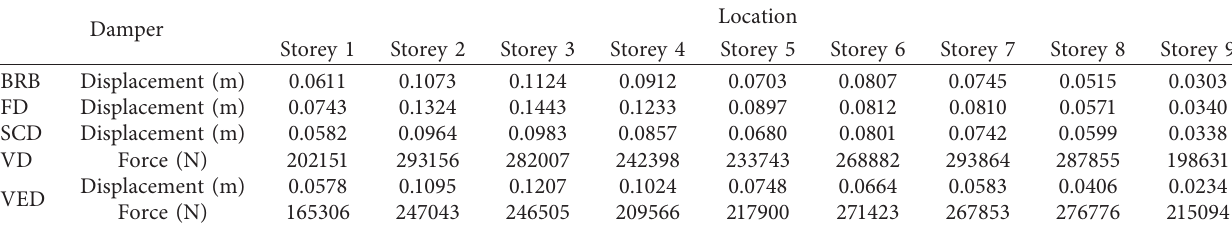
Table 4: Limit values of displacement and force of five